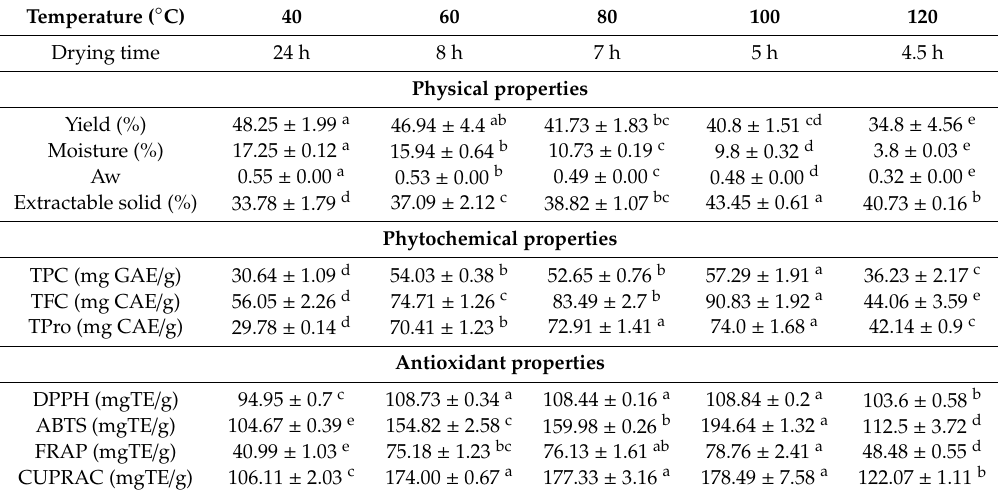
Table 2. Impact of vacuum drying on physicals, phytochemicals and antioxidant property of Tuckeroo fruits. Temperature ( ◦